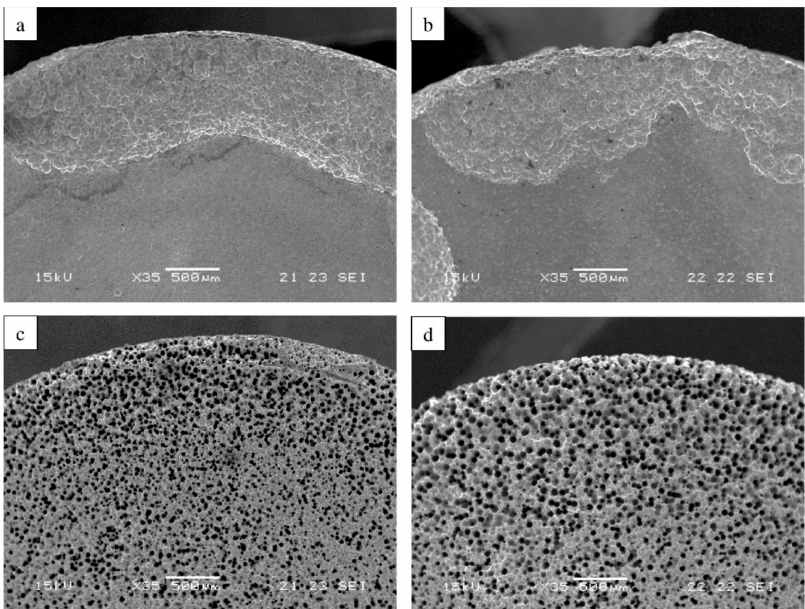
Figure 8. Close-up views of corrosion attack at the surface of printed ER70S-6 and reference ST-37 alloys after immersion tests in 3.5% NaCl solution, as obtained by SEM: ( a , b ) printed alloy after an exposure times of 60 days and 90 days, respectively; ( c , d ) reference alloy after exposure times of 60 days and 90 days,